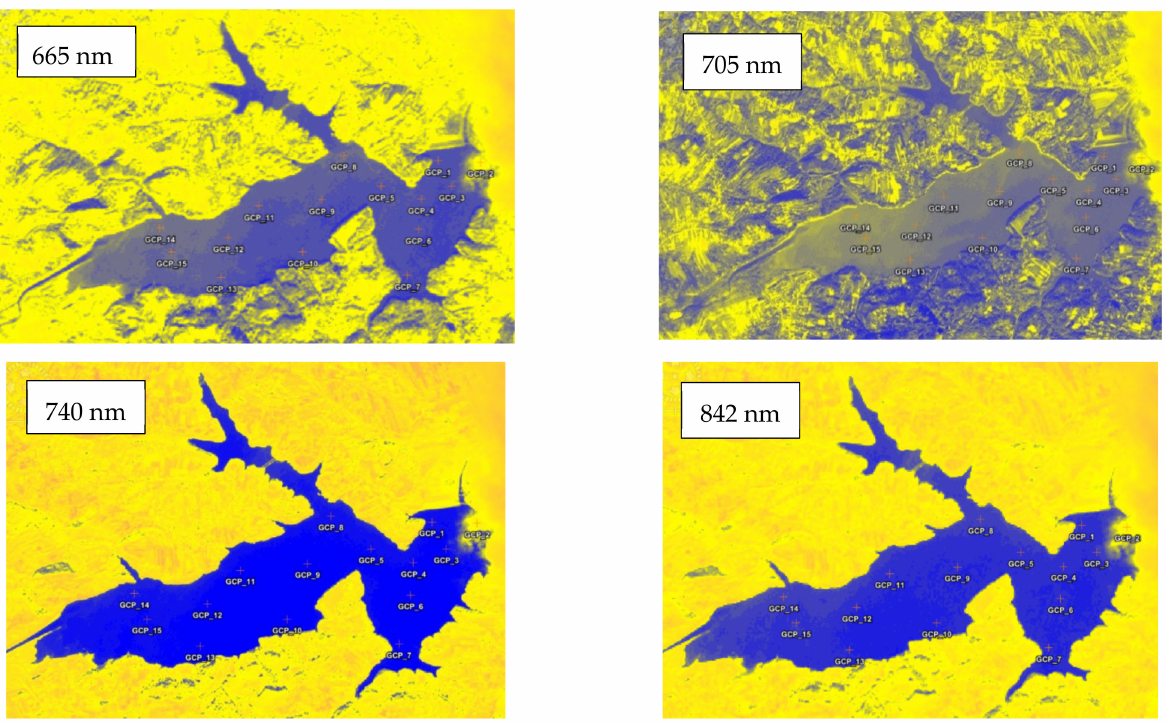
Figure 11. Images of Lake Dobczyce at four wavelengths (color representation: blue, yellow, violet, with the same color saturation in each